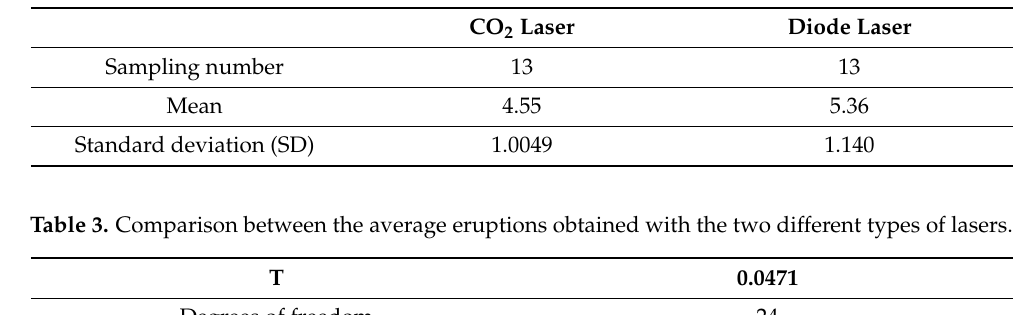
Table 2. Comparison between the average eruptions obtained with the two different types of lasers. CO 2 Laser Diode Laser